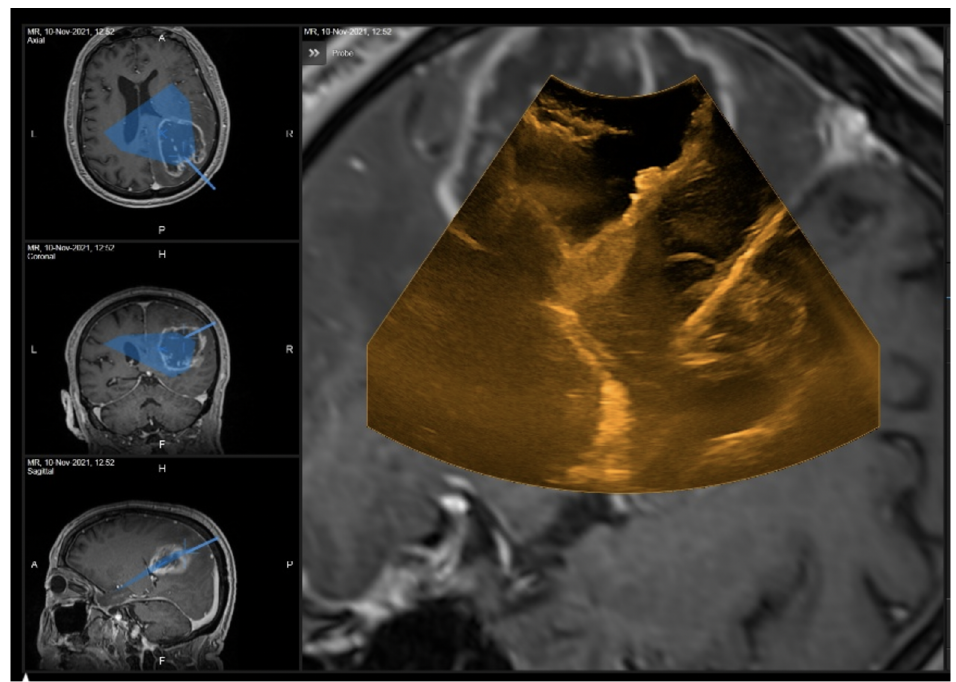
Figure 12. 2D iUS scan performed at the 100% surgical resection stage. No obvious residual disease was found.